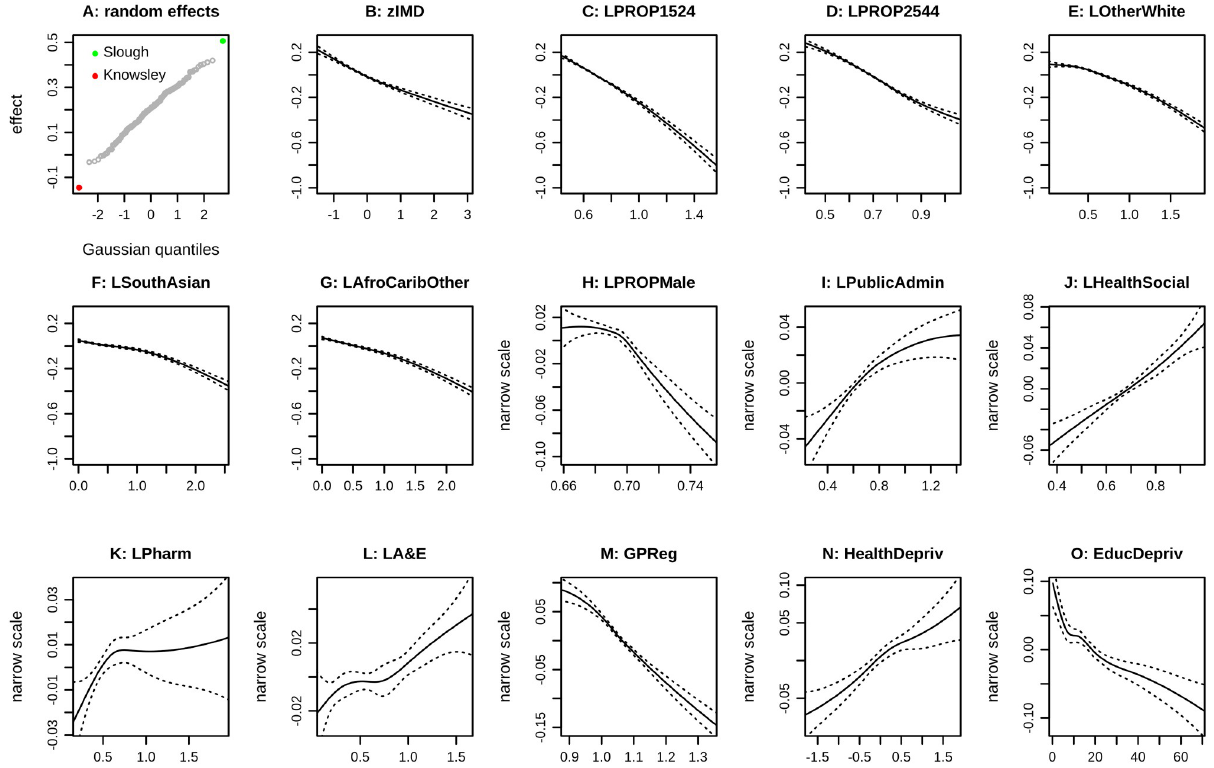
Fig 2. Selected smoothers for model D for the Third Injection. The panels show the modelled impact of individual covariates on the overall fitted value (displayed on the scale of the linear predictor, before it is translated to fitted output by the inverse link function). The x-axis is limited by the 0.01 and 0.99 quantiles of the covariate. In some panels the y-axis is limited by the range of the smoother and is labelled “narrow